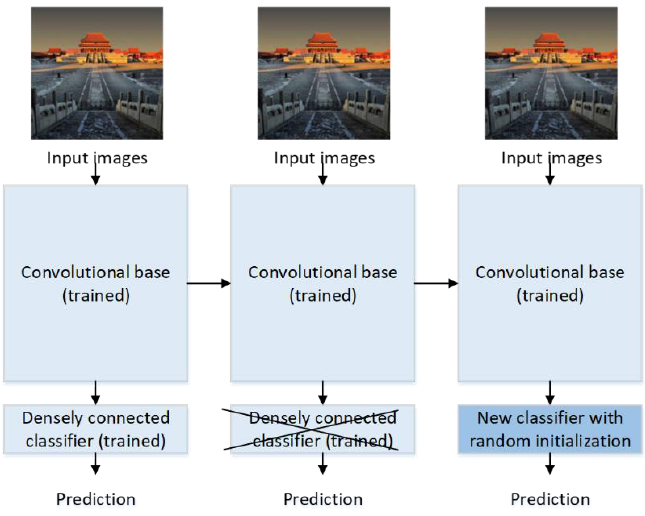
Figure 4. Displacing classifiers of the pre-trained CNN and freezing its convolutional base.